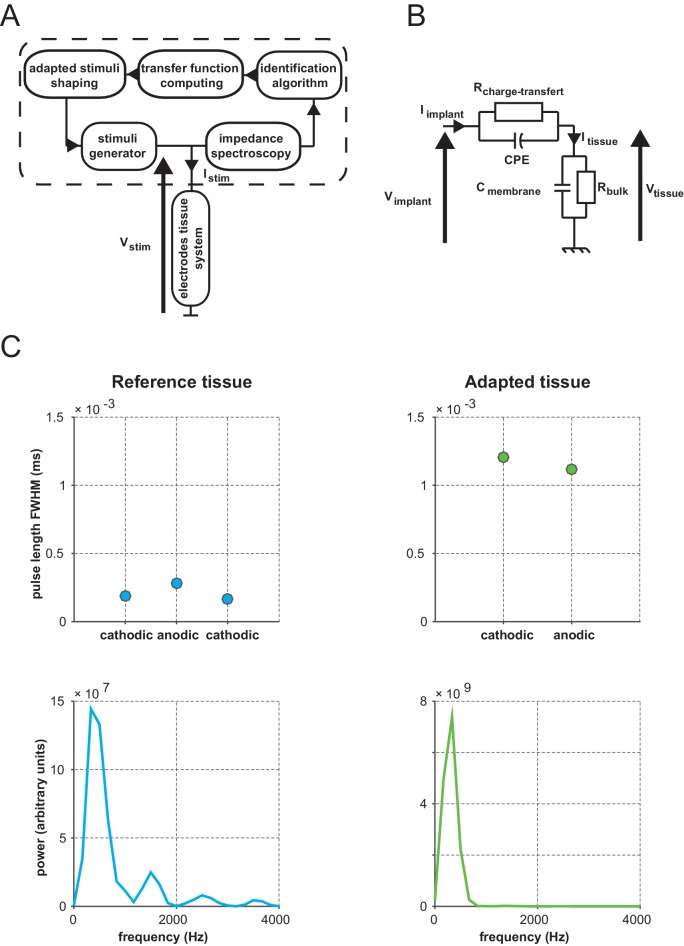
Principle of IS adaptation.(A) The stimuli processing platform’s architecture integrates an Impedance Spectroscopy (IS) recording module; an Identification Algorithm module fitting IS data to an Electronic Equivalent Circuit (EEC); a Transfer Function Computing module and an Adapted Stimuli Shaping module computing adapted stimuli emitted by the Stimuli Generator. (B) Linear EEC used for this study. I: current; V: voltage; CPE: constant phase element (capacitance of the electrical double layer formed at the interface between a metallic electrode and an ionic solution); C: retinal membrane capacitance; R: resistance; bulk: subretinal fluid. (C) Mean duration (top) and frequency content (bottom) of reference (left) and IS adapted (right) pulse shapes recorded in the tissue (reference pulses: cathodic first symmetrical biphasic squared pulses). Duration: full width at half maximum (FWHM) of each recorded transients for the reference pulses (corresponding to the 3 abrupt pulse transitions) and of the 2 sustained phases for the adapted ones. Frequency: power of the Fourier transformed computed on the pulses temporal profiles.